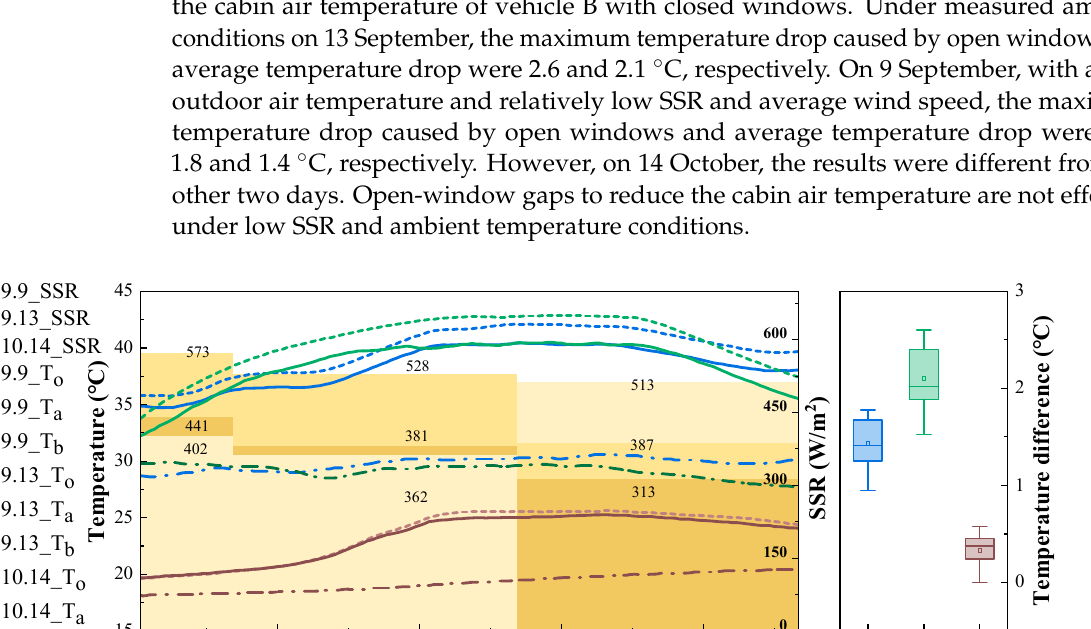
Table 4. Ambient conditions on 9 September, 13 September, and 14 October.